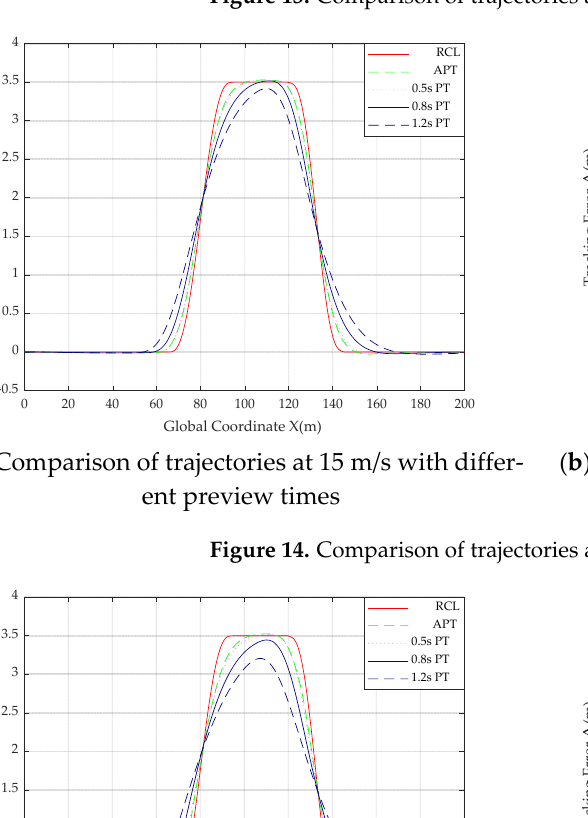
( b ) Comparison of trajectories at 10 m/s with differ ‐ Figure 13. Comparison of trajectories and tracking error with different preview times at 10 m/s.